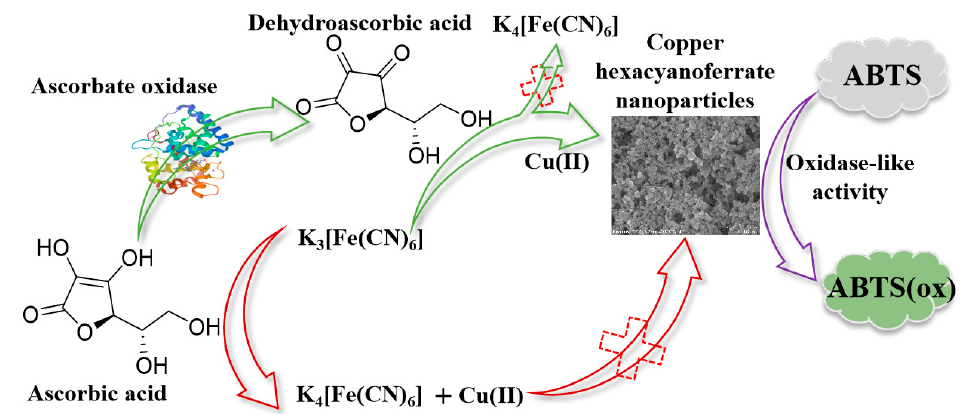
Figure 1. Schematic illustration of enzyme-regulated in situ formation of copper hexacyanoferrate nanoparticles with oxidase-mimetic behaviour for colorimetric detection of ascorbate oxidase.